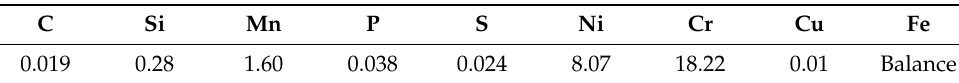
Table 3. Chemical composition of SS 304.